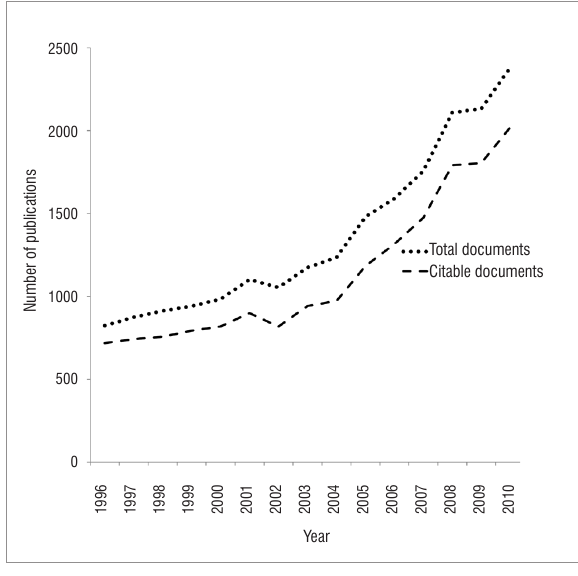
Growth in the total number of documents published and the total number of citable documents published on medical research in South Africa during 1996–2010.